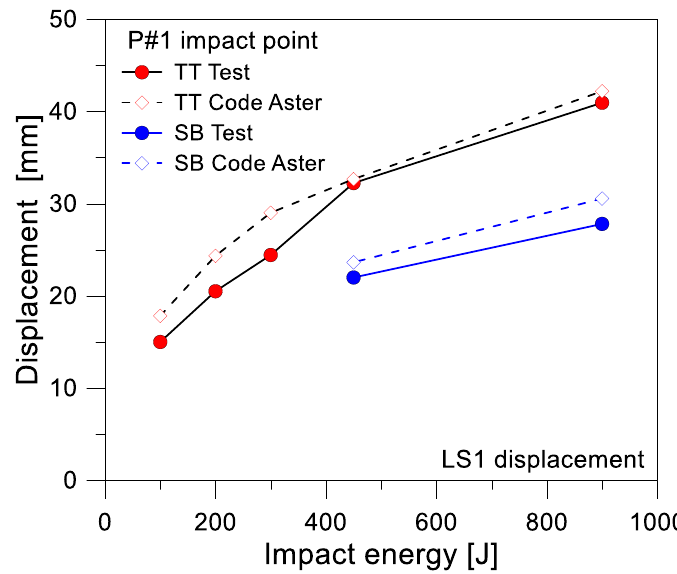
Figure 18. Comparison of numerical and experimental peaks of displacement (LS1) for the curtain wall under various impact conditions, as a function of the impact energy.